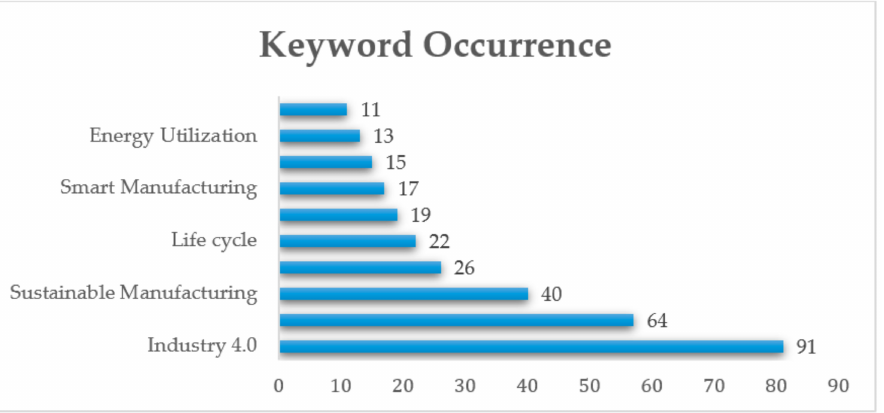
Figure 5. Main keywords used in articles related to Industry 4.0 and manufacturing